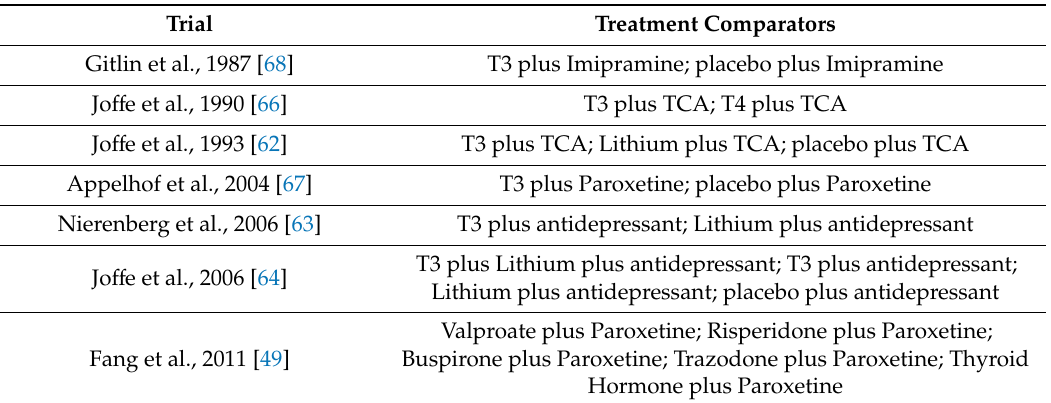
Table 5. List of Included Thyroid Hormone